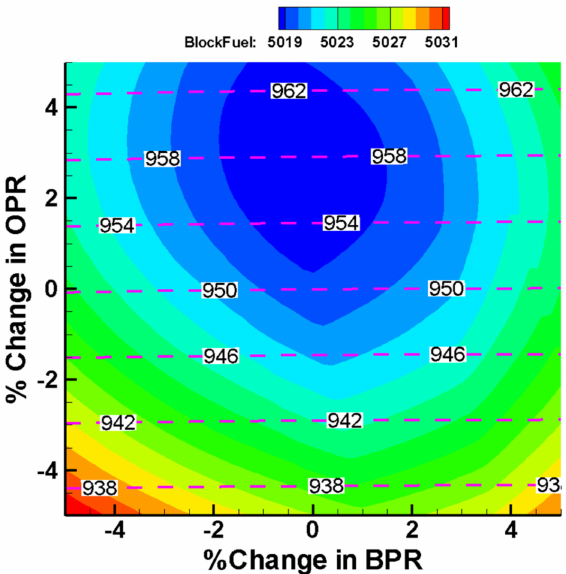
Figure 7. FB Contour plot with OPR and BPR at ToC and CDT isolines (dashed lines) at MCR.